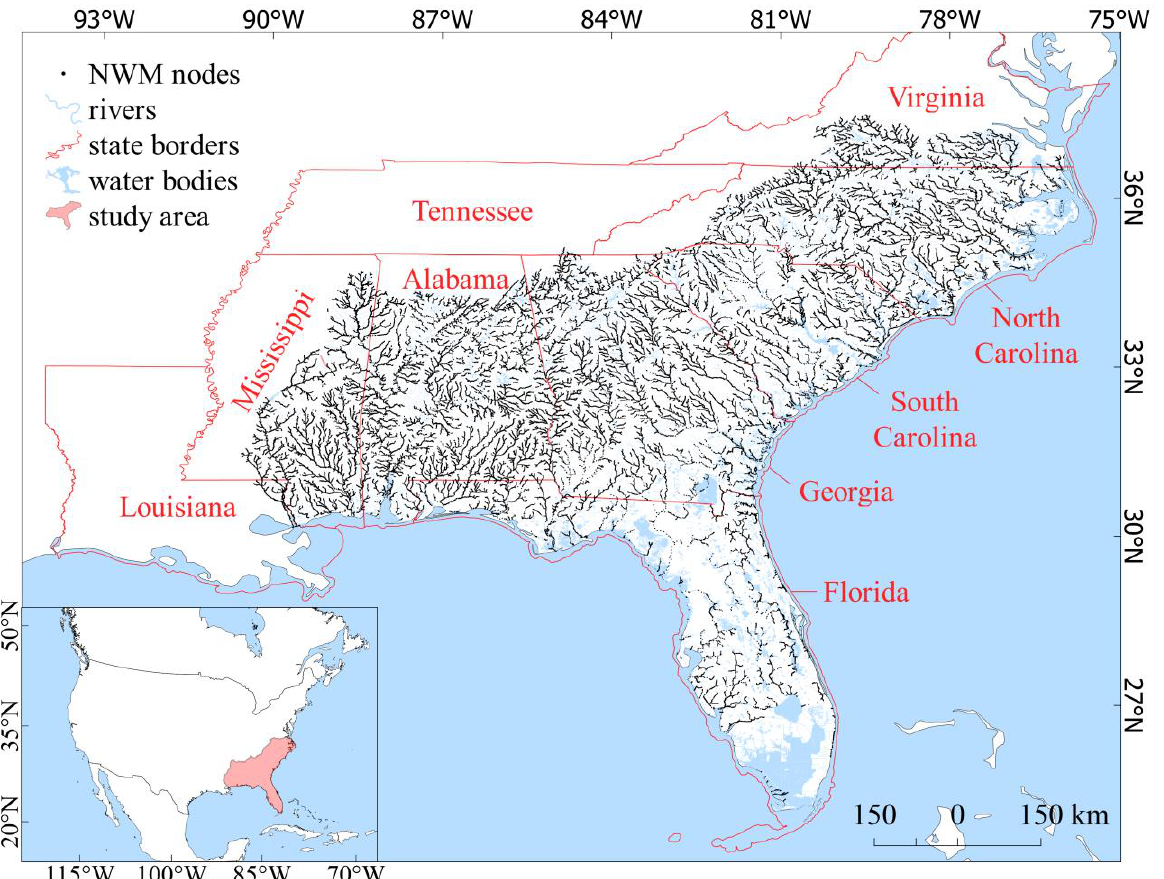
Figure 1. Southeast US study area with locations of NWM nodes.